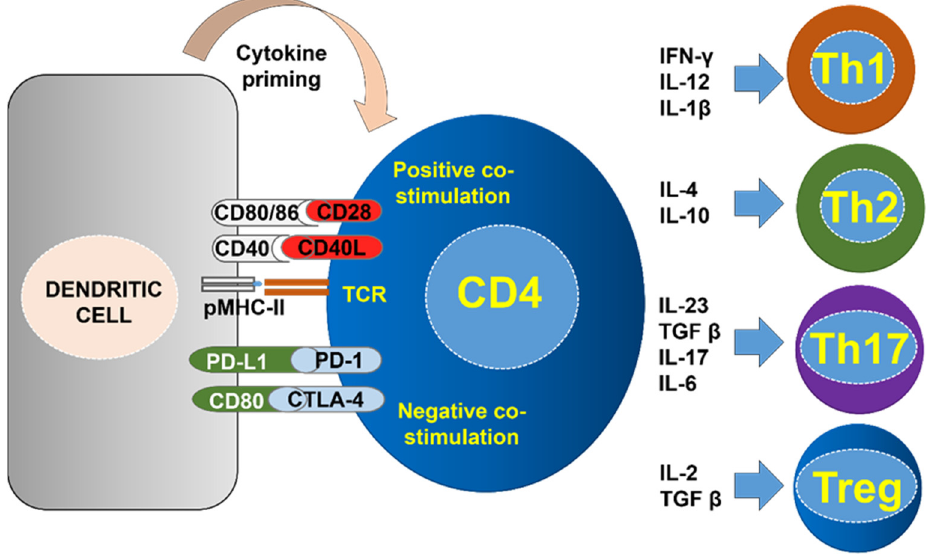
Figure 2. Three signal model of antigen presentation to T cells and differentiation into CD4 T helper subtypes. On the left, a dendritic cell presents antigenic peptide complexes with MHC-II to the CD4 T cell. TCR recognition drives signal 1. Then, CD4 T cells receive both positive co-stimulation and negative co-stimulation as shown in the figure. Some representative receptor-ligand interactions from both types of co-stimulation are shown in the figure. The integration of these signals results in distinct activation degrees. A third cytokine signal is also provided by the dendritic cell which determines the differentiation fate of the CD4 T cells. On the right, examples of cytokines which drive CD4 T cell differentiation to the main T helper subtypes as shown. Regulatory T cells can also be differentiated from uncommitted CD4 T cells as shown in the figure.